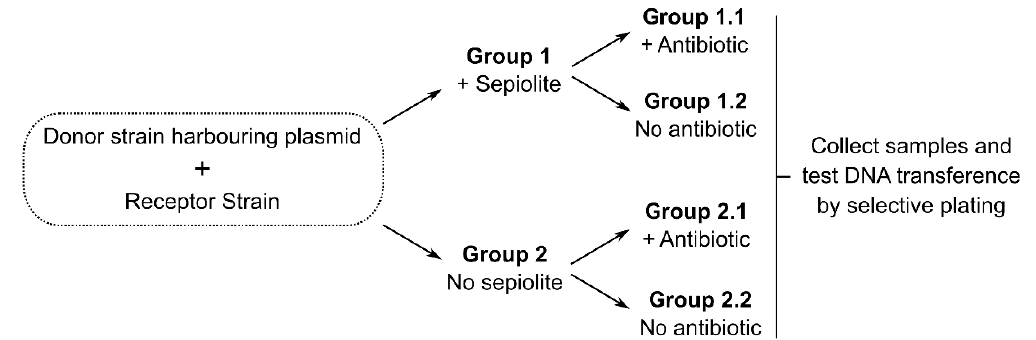
Figure 2. Ideal experimental model for testing the stated hypothesis. All germ-free